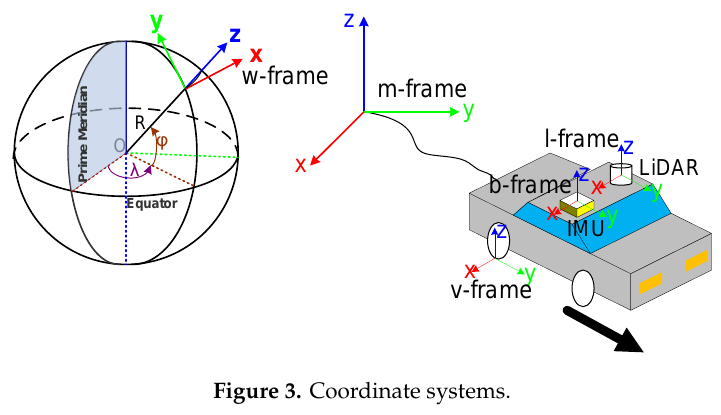
Figure 3. Coordinate systems.